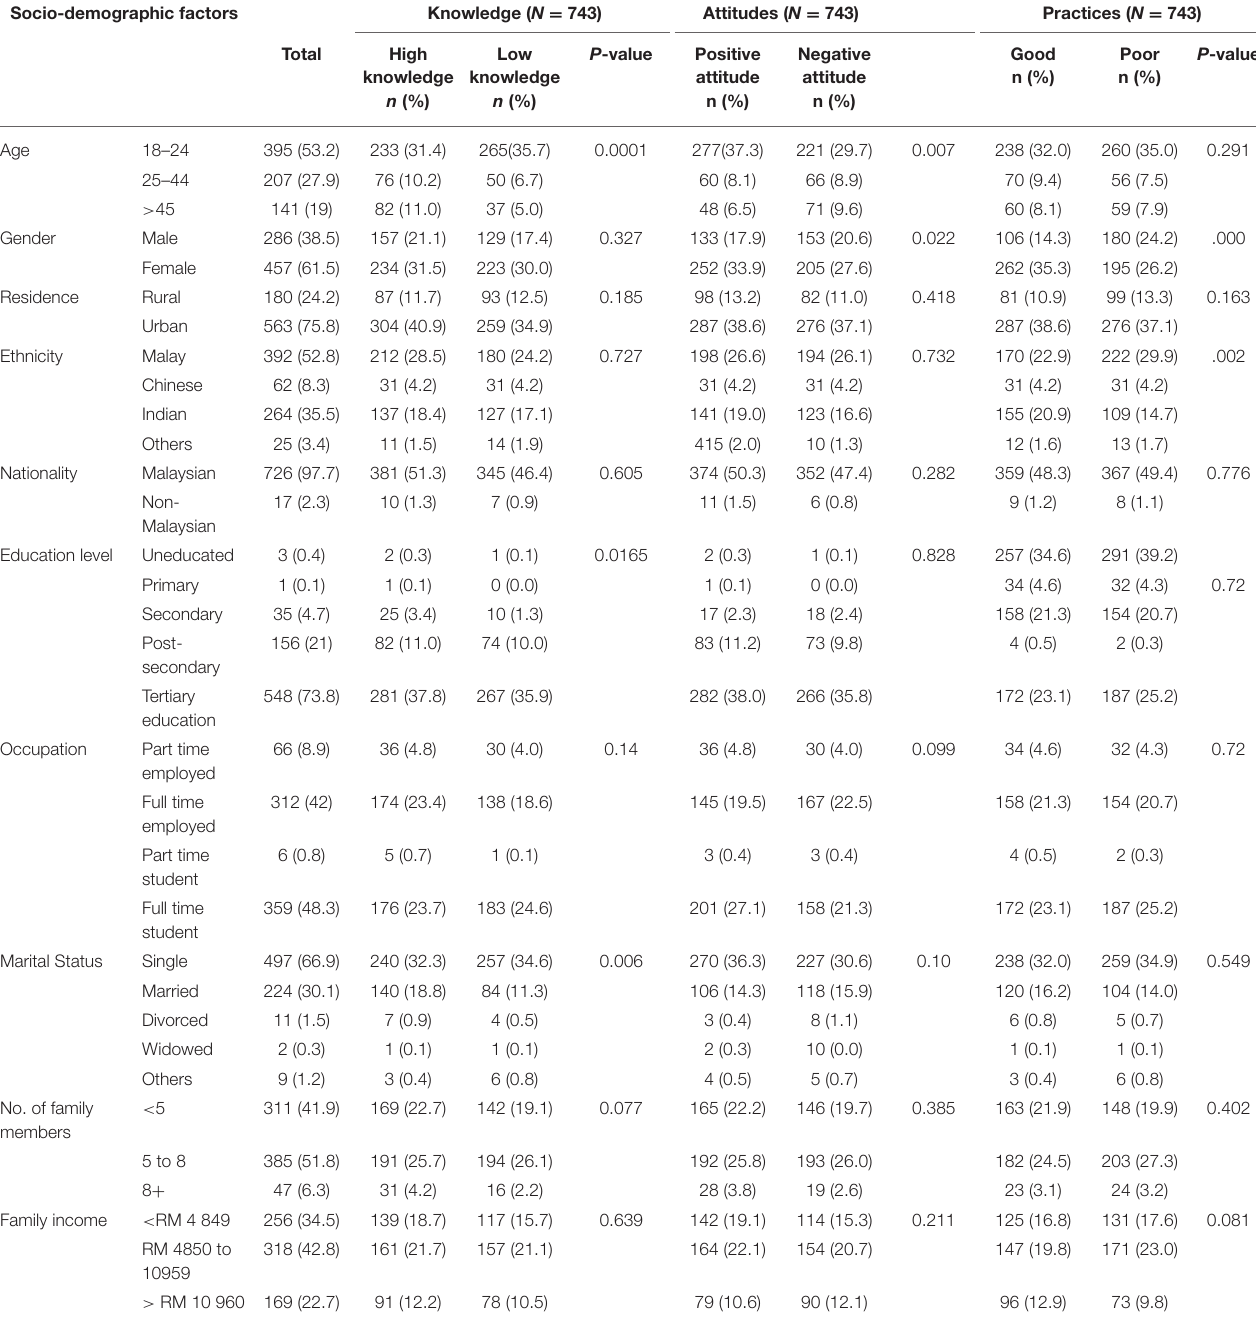
TABLE 1 | Socio-demographic association of person’s knowledge, attitude and practices. Socio-demographic